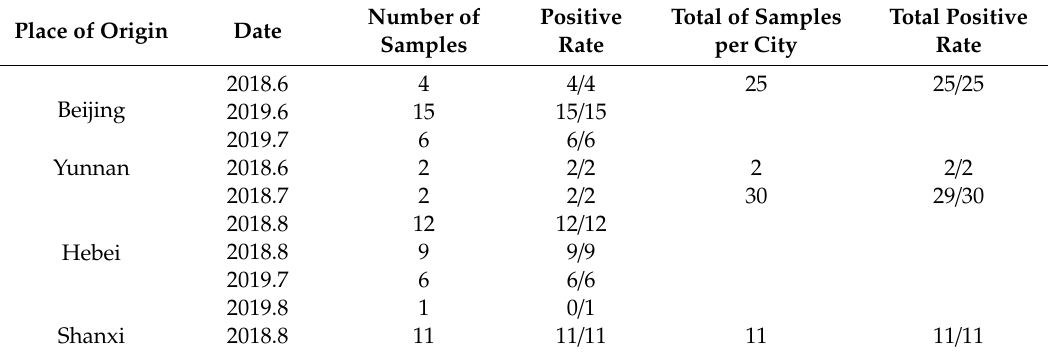
Table 1. Detection results of ostrich parvovirus (OsPV) in clinical